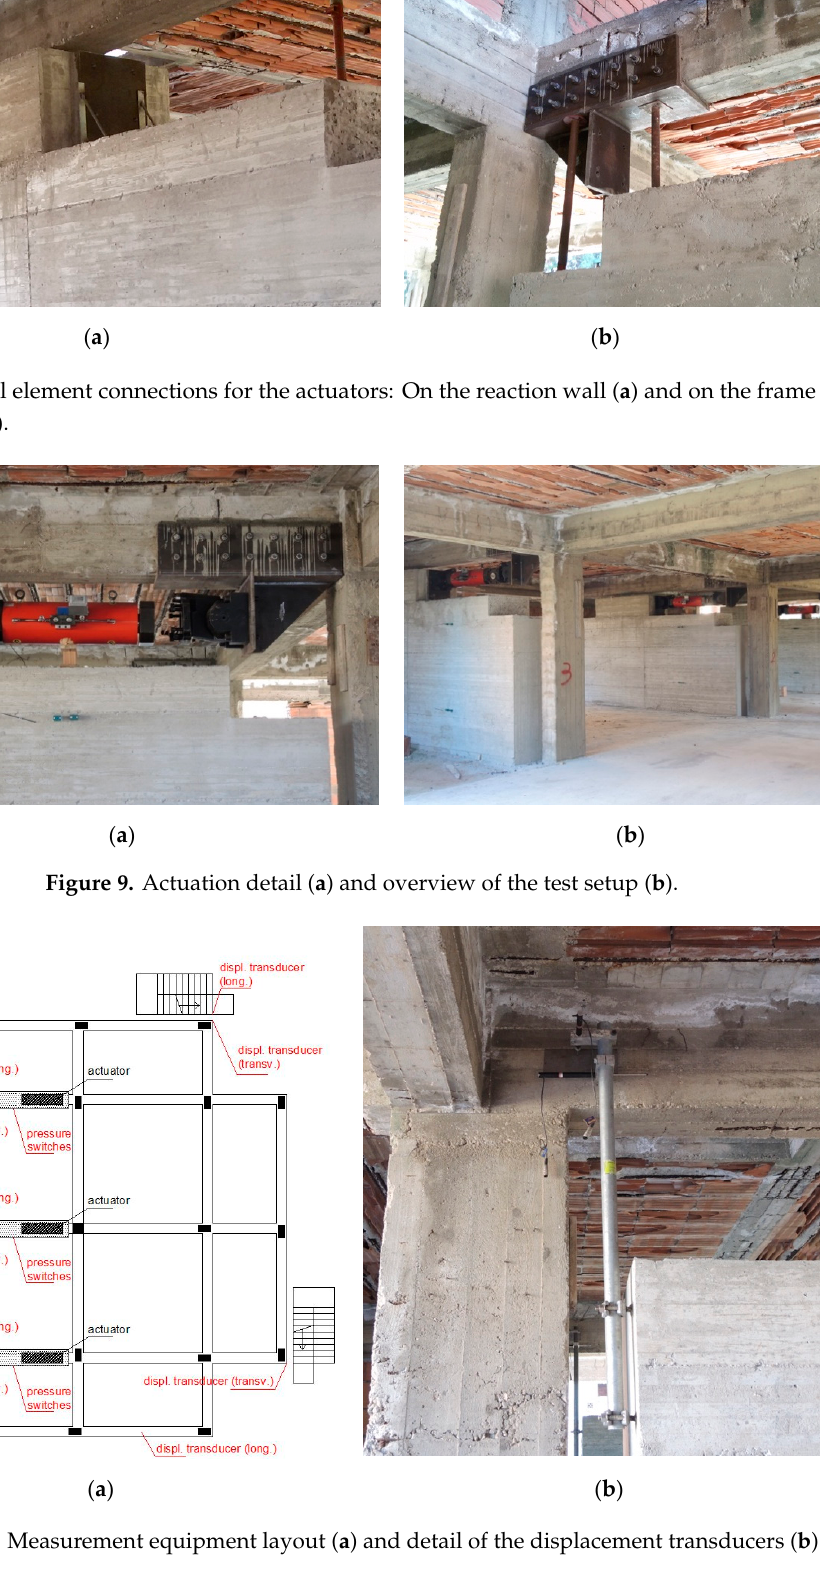
Figure 10. Measurement equipment layout ( a ) and detail of the displacement transducers ( b ).